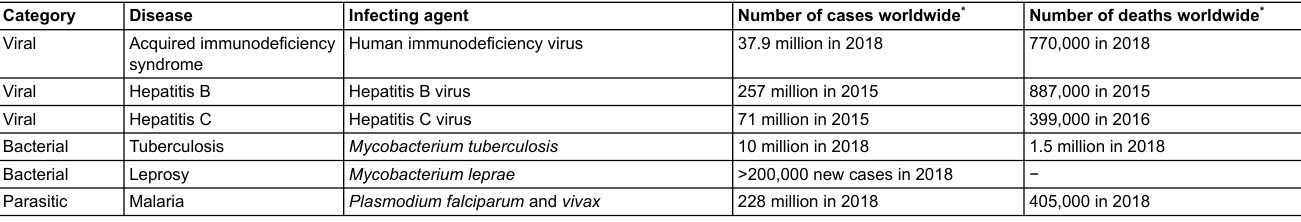
Table 1: Six of the most prevalent infectious diseases according to the World Health Organization.